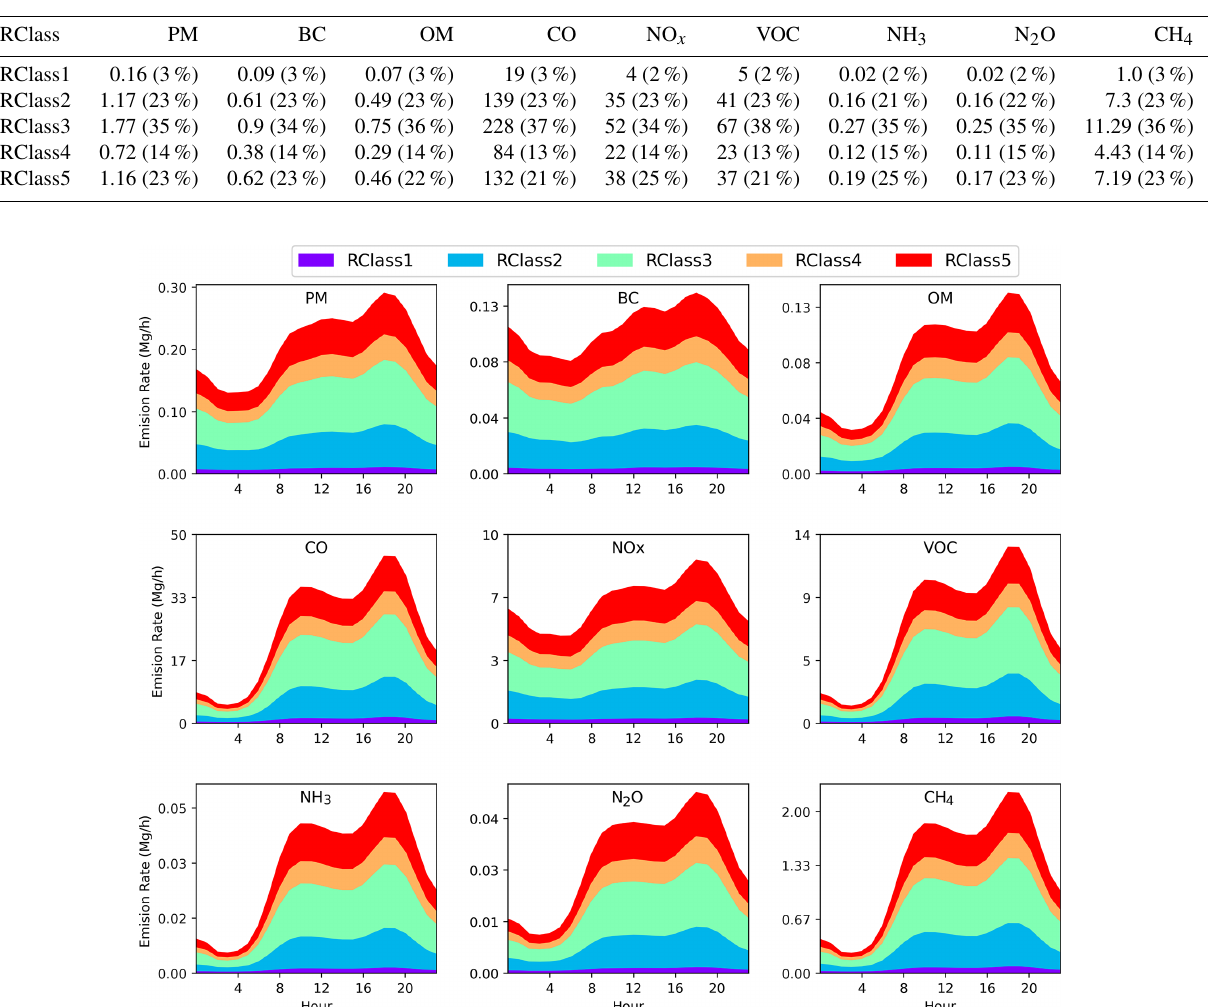
Table 1. Emission in megagram (Mg) per day (% share) across different road types.